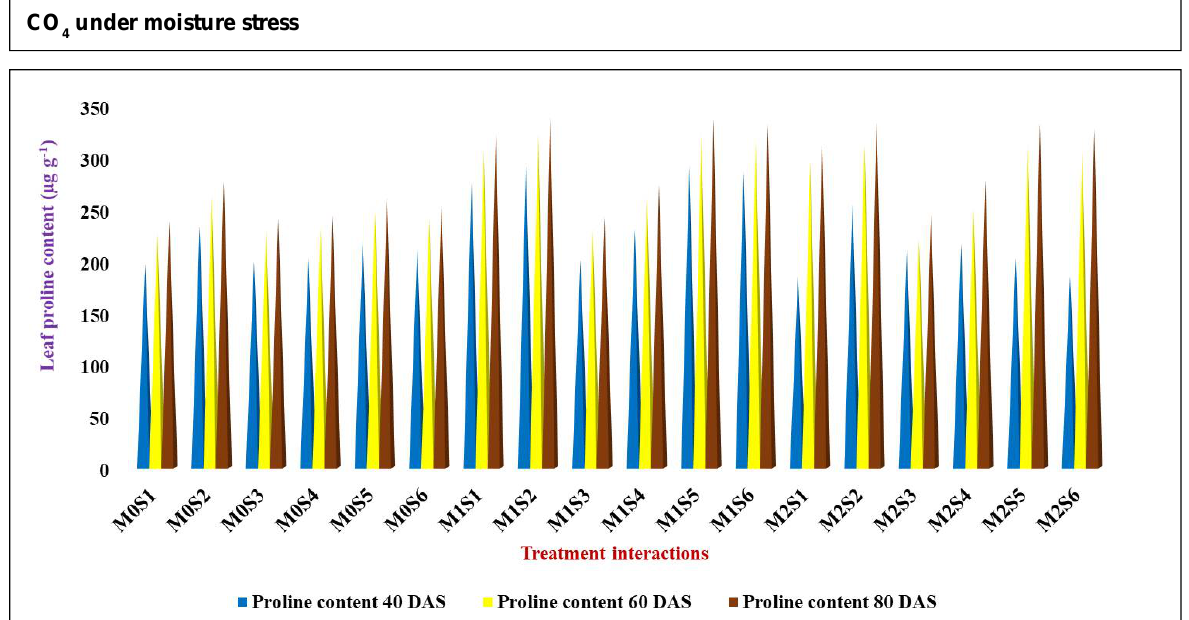
Figure 2: Effect of plant growth regulating chemicals on leaf proline content ( µ g g –1 ) of bhendi hybrid CO under moisture